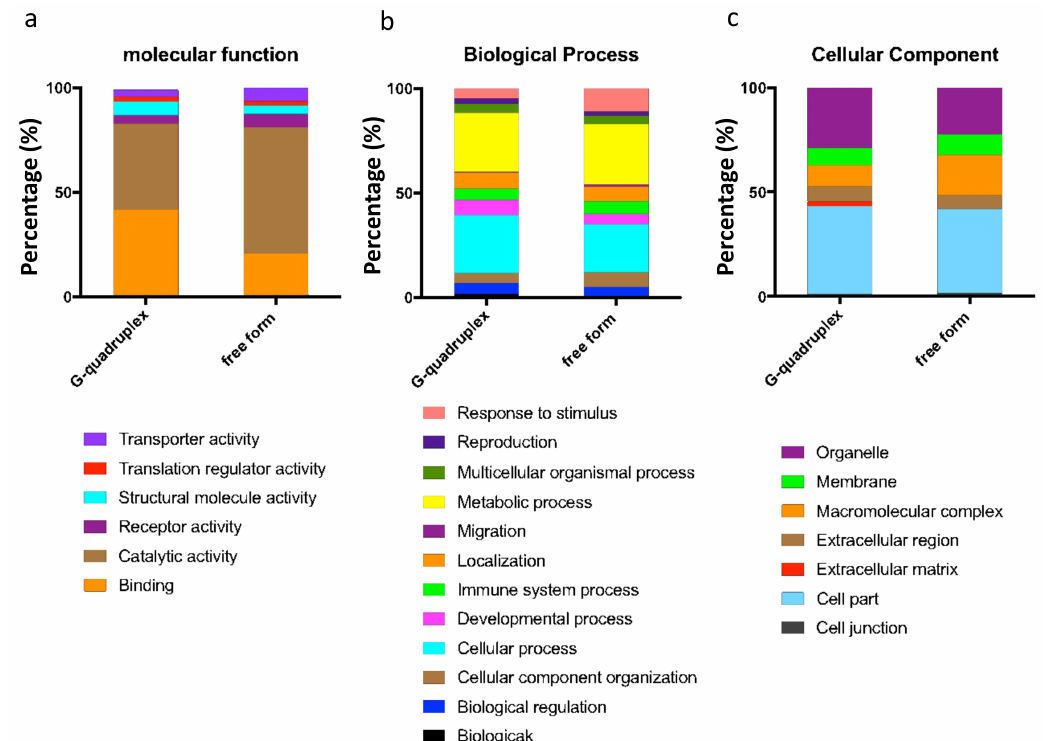
Figure 1. Panther analysis of the comparison between 182 kinds of G-quadruplex binding proteins and 133 free from binding proteins in ( a ) Molecular Function, ( b ) Biological Process, and ( c ) Cellular Component. In the molecular function classification, the binding-related protein in the chip of free-form miR-1587 decreased, and the protein with catalytic activity increased, which showed obvious differences. In the biological process classification, the cellular process proteins in the chip of free-form miR-1587 decreased while the response to stimulus-related protein displayed obvious improvement. In the cellular component classification, both cell part and organelle-related protein decreased, while macromolecular complex related molecules